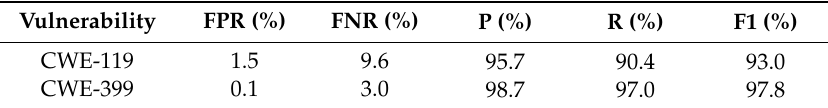
Table 6. Performance of our method on di ff erent types of vulnerability.